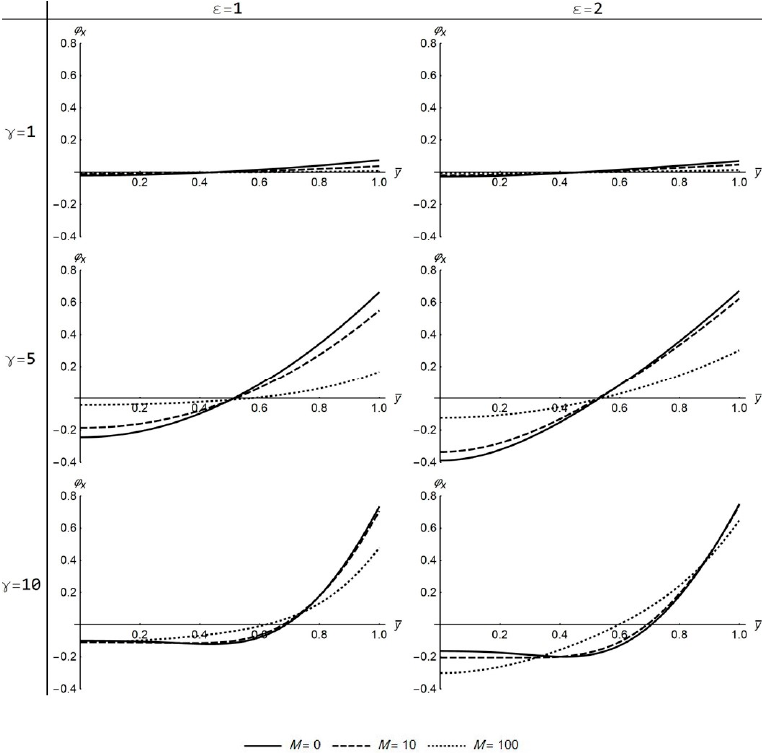
Figure 5. The profiles of 𝜑 (cid:3051) for different values of the 𝜀 , 𝛾, and 𝑀 parameters (transverse case).